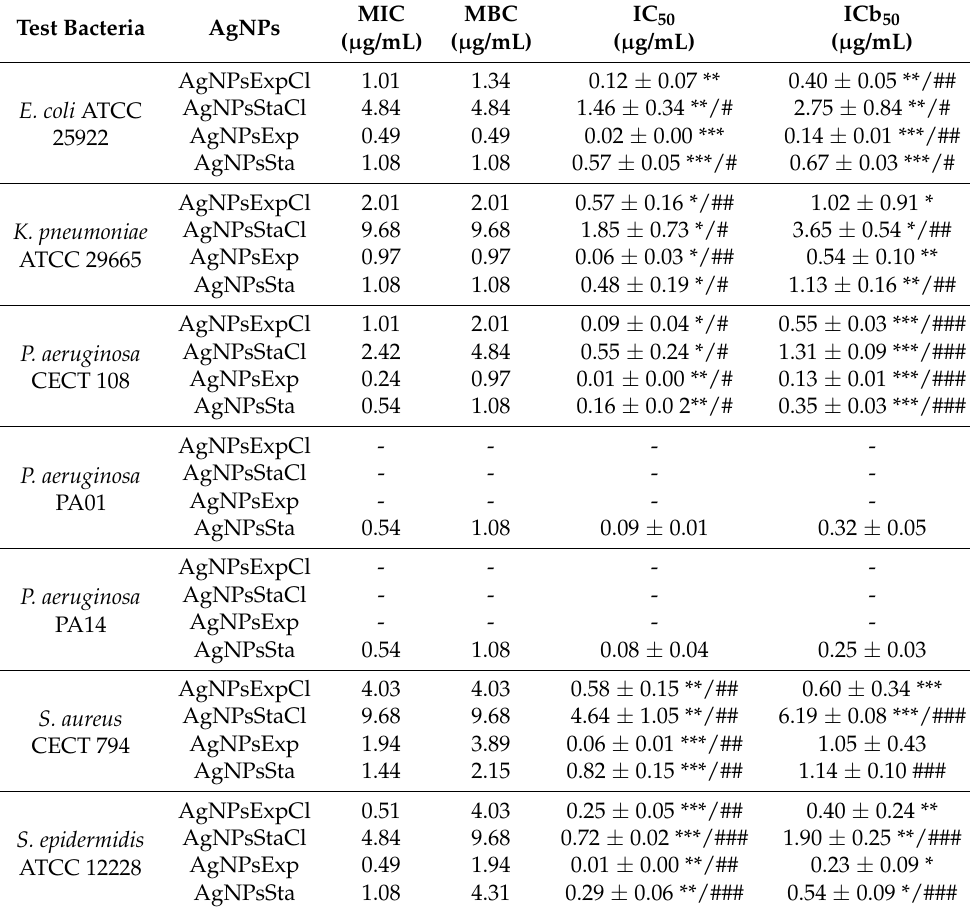
Table 2. Antimicrobial and antibiofilm activity. Test